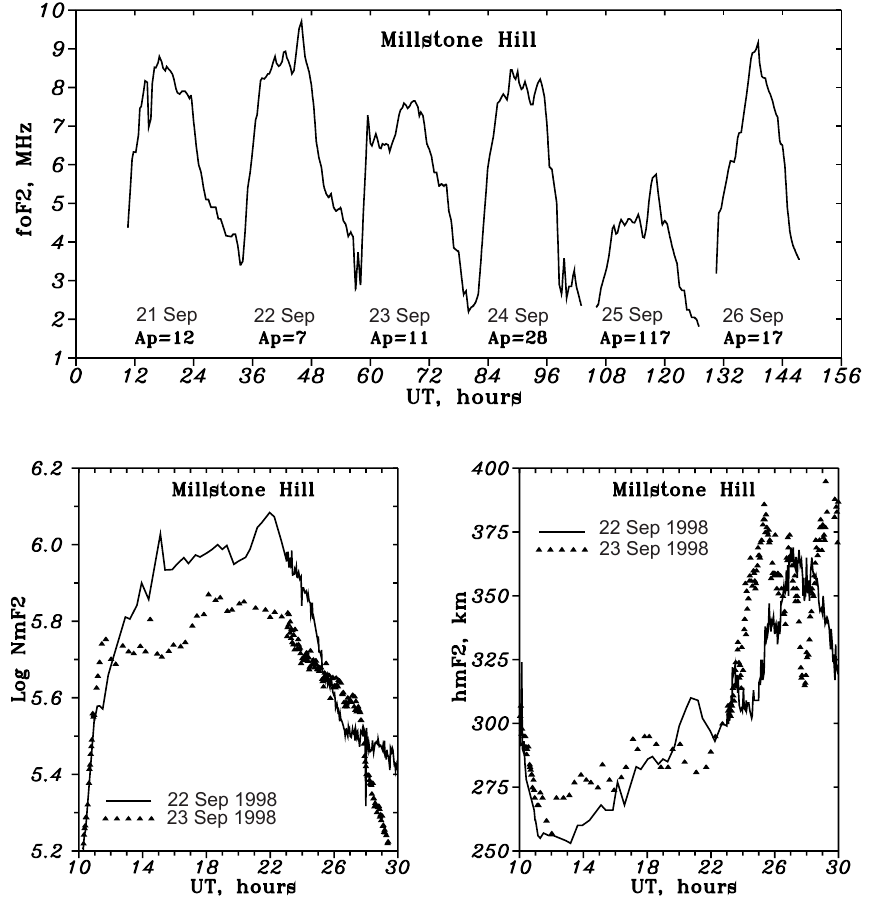
Fig. 8. Daily fo F2 variation for suc- cessive days during an autumnal transi- tion period at Millstone Hill (top panel). Daily Ap indices are given as well. Bot- tom panels show diurnal NmF2 and hm F2 variations for a winter-like (22 Sep 1998) and summer-like (23 Sep 1998) day analyzed for thermospheric parameter variations (LT = UT −